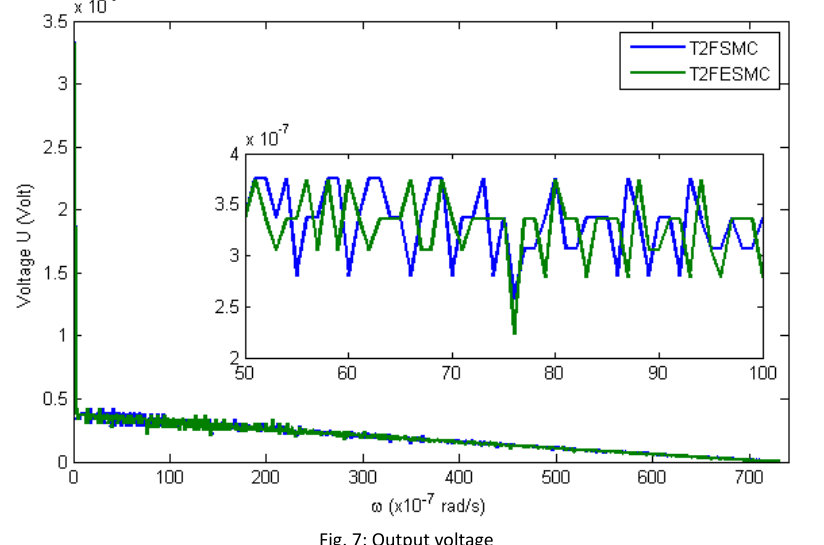
Fig. 7: Output voltage Table 2: DC motor system parameters (Mardlijah et al., 2018)